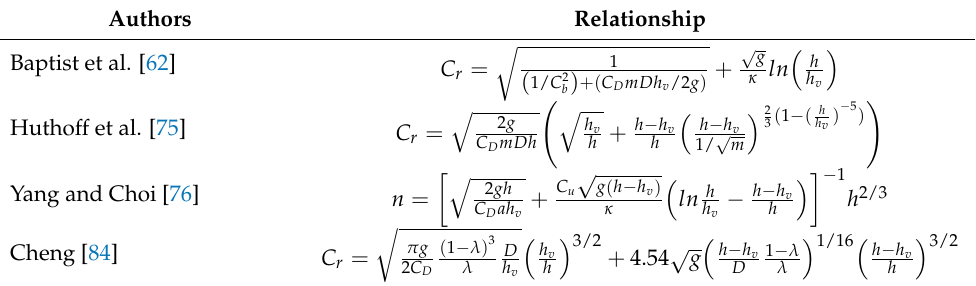
Table 2. Equations for estimating C r and n in case of submerged rigid vegetation.